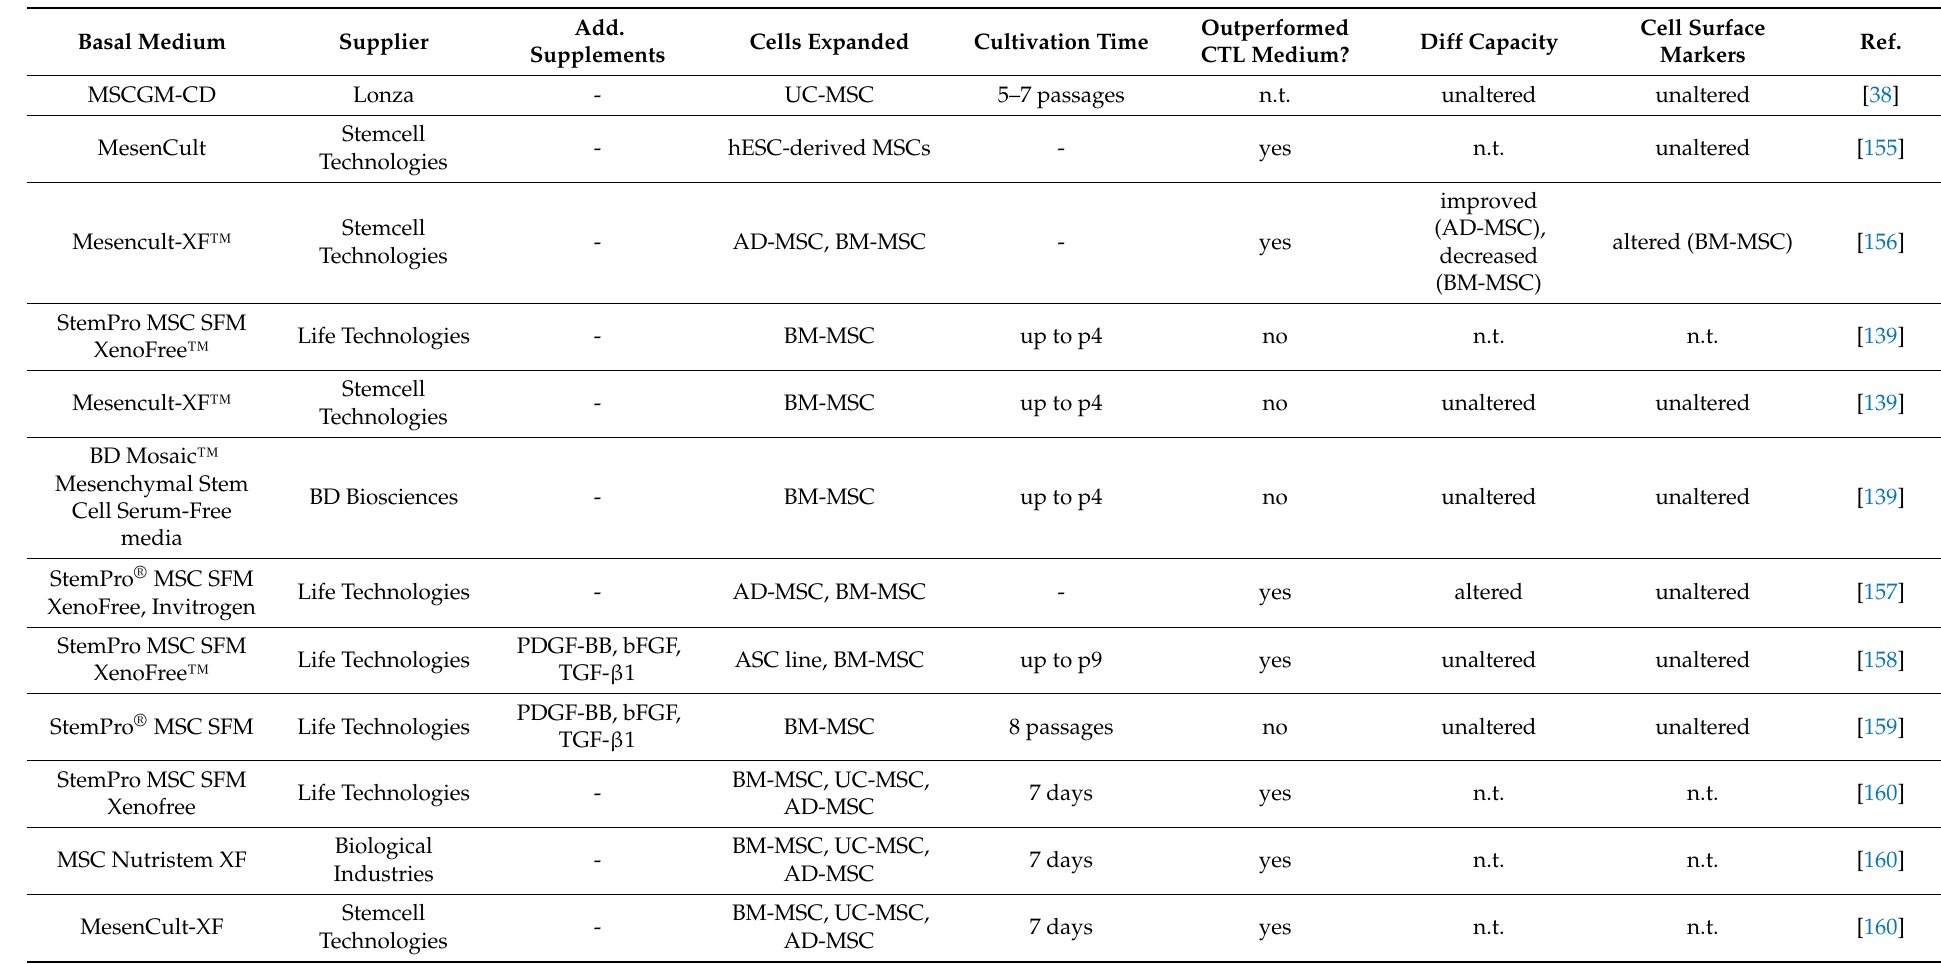
Table 4. Commercially available, chemically defined/serum-free/xeno-free media tested for expansion of hMSCs; including selected studies from 2010–2021. Information is given on brand name, supplier, any added supplements, the cell source, cultivation parameters, and stem cell